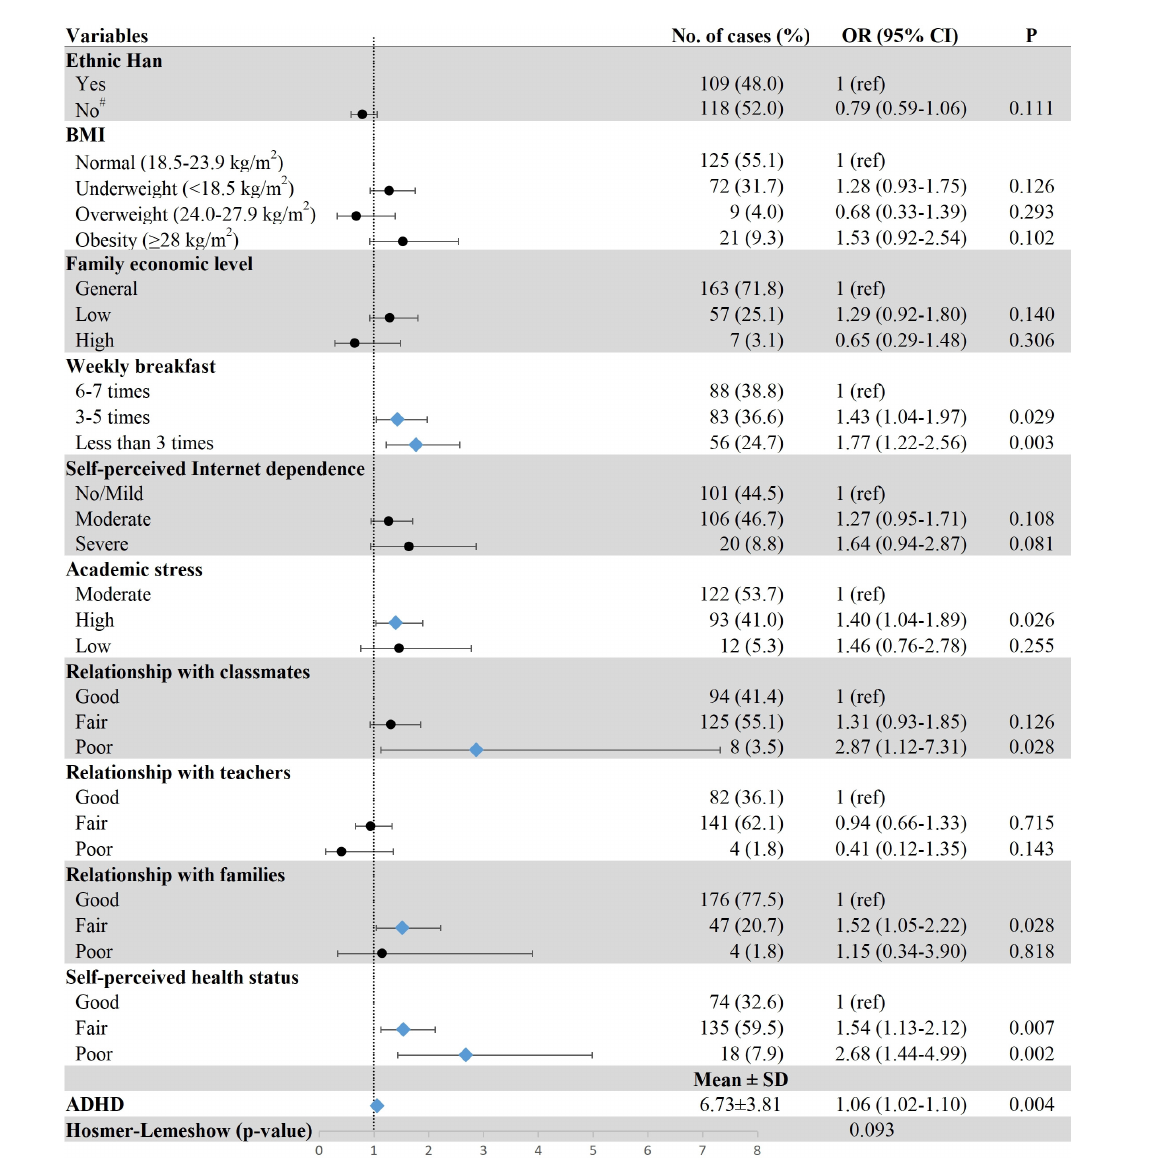
FIGURE2 Associations between demographic and clinical characteristics and DIS. Row with blue diamond indicates statistical significance. # Ethnic minorities including the Tibetan, Hui, and Tu. ADHD, attention-deficit/hyperactivity disorder; BMI, body mass index; DIS, difficulties initiating sleep; OR, odds ratio; 95% CI, 95% confidence